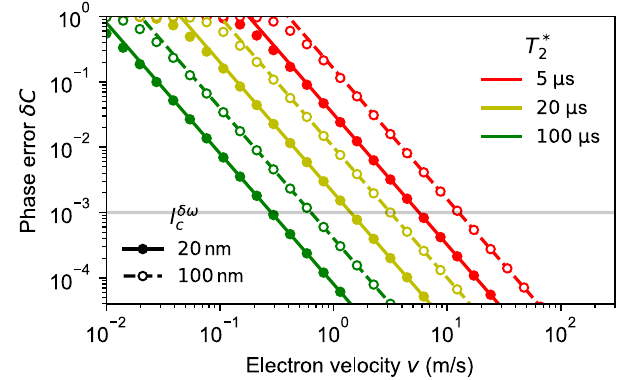
FIG. 8. Improvement of spin coherence of an electron trans- ferred adiabatically along a 10 µ m long channel with its velocity. We plot the coherence error due to quasistatic noise as a func- = 5, 20, tion of velocity for dephasing times of static spin T ∗ 2 100 µ s, and two values of spatial autocorrelation length of qua- = 20 nm (corresponding sistatic disorder in spin splitting: l δω c = 100 nm ≈ l δ V (corresponding to to typical QD size) and l δω c c typical electrostatic disorder autocorrelation length, see Fig. 9). Lines correspond to Eq. (4) that holds when δφ (cid:6) 1, while cir- cles correspond to the formula, δ C = 1 − e − δφ 2 / 2 , which holds for Gaussian statistics of random phase